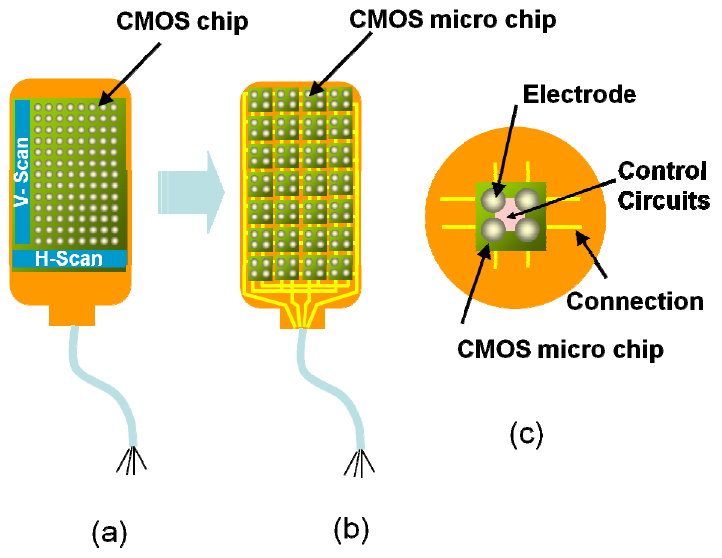
Figure 9. Realization of a large number of electrodes using CMOS technology. (a) CMOS chip. (b) Multiple microchip architecture. (c) Schematic diagram of the microchip (adapted from